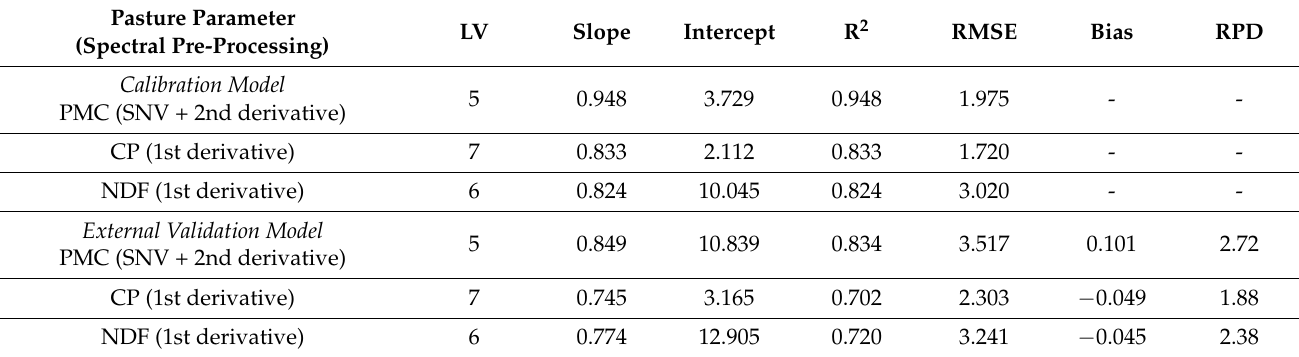
Table 2. Statistics regarding calibration and external validation models of pasture moisture content (PMC), crude protein (CP) and neutral detergent fiber (NDF) in fresh samples using near-infrared spectroscopy (NIRS) spectra and partial least squares regression (PLSR).